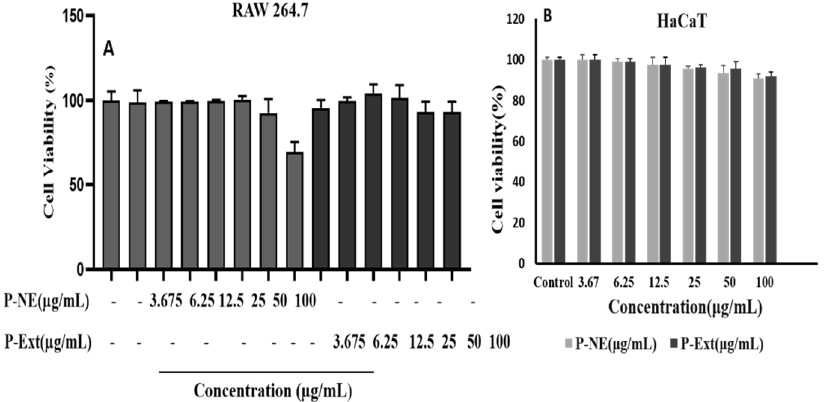
Figure 4. Effect of Panos nanoemulsion on cell viability in ( A ) RAW 264.7; ( B ) HaCaT. Cell